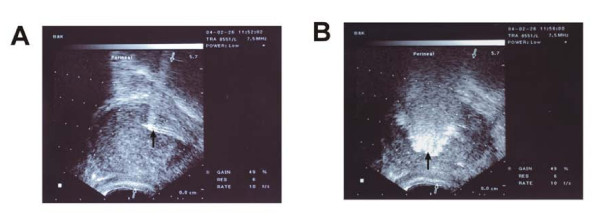
A. Confirmation of needle (black arrow) within the human prostate, longitudinal view. B. Diffusion of hyperechoic BTX-A (black arrow) over the prostate immediate post injection.